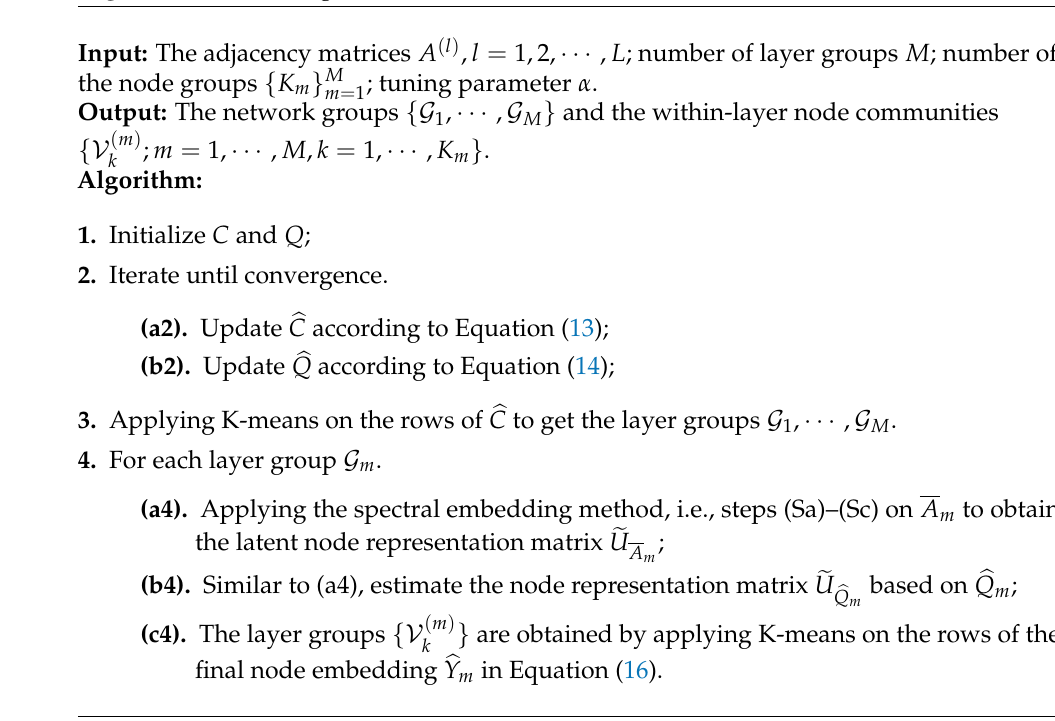
Algorithm 1 MFSE